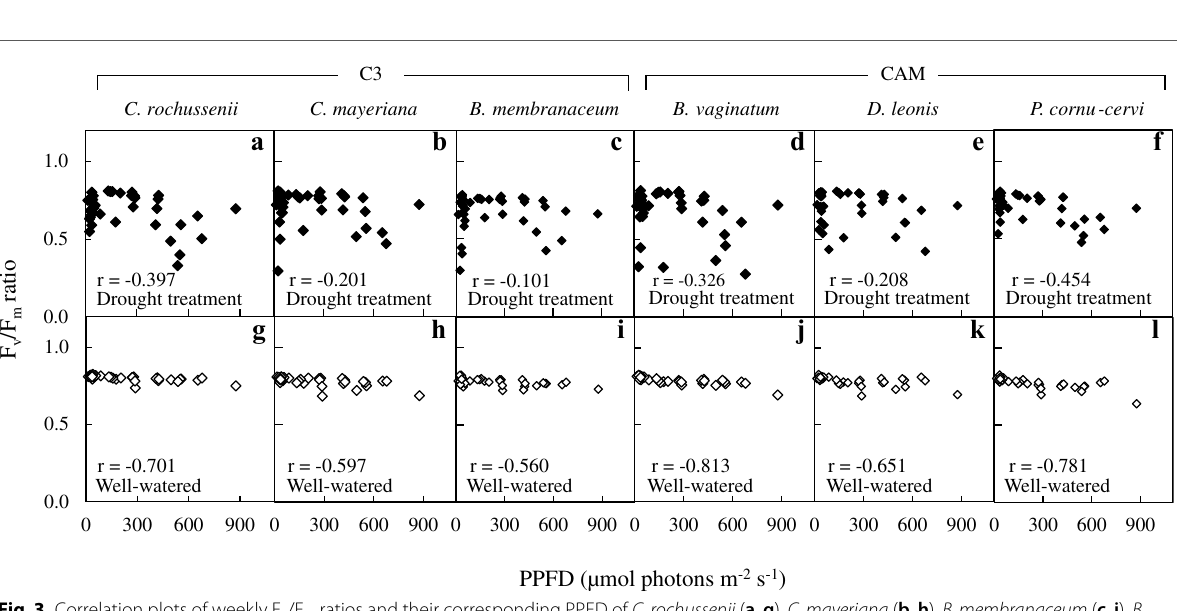
Fig. 3 Correlation plots of weekly F v /F m ratios and their corresponding PPFD of C. rochussenii ( a , g ), C. mayeriana ( b , h ), B. membranaceum ( c , i ), B. vaginatum ( d , j ), D. leonis ( e , k ), and P. cornu - cervi ( f , l ) under drought treatment versus well-watered conditions. Pearson correlation coefficient (r value) is shown for each species. Vertical bars represent standard error. Different letters above bars indicate statistical difference (Tukey’s multiple comparison, p < 0.05, n =